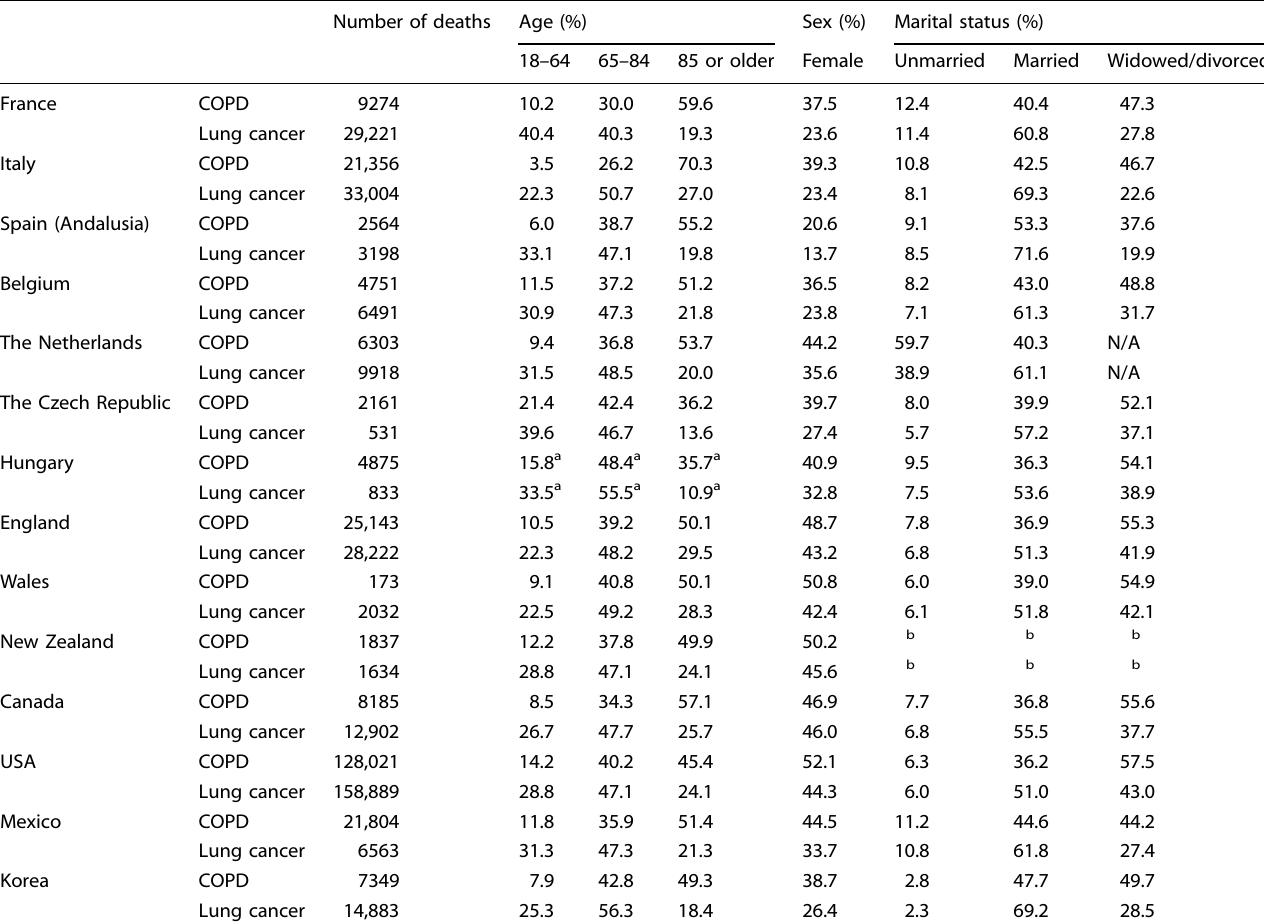
Table 2. Demographic characteristics of people with COPD or lung cancer who died during 2008 in 14 countries ( N =